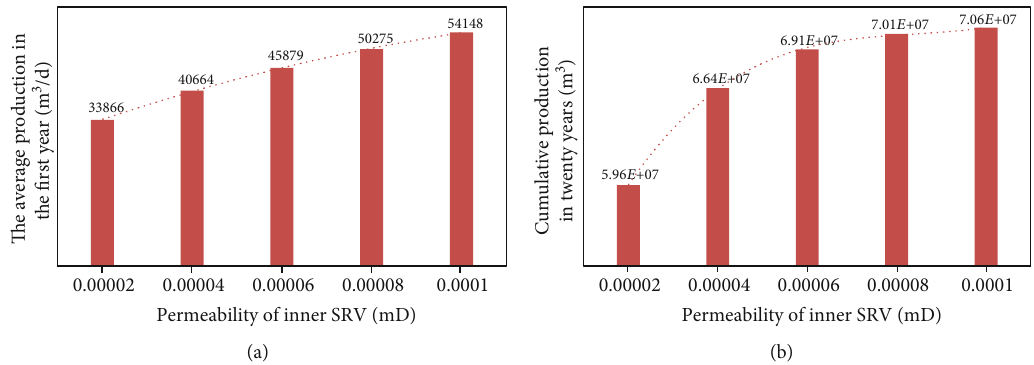
Figure 8: E ff ects of the permeability of inner SRV on gas production rate (a) and cumulative production (b).